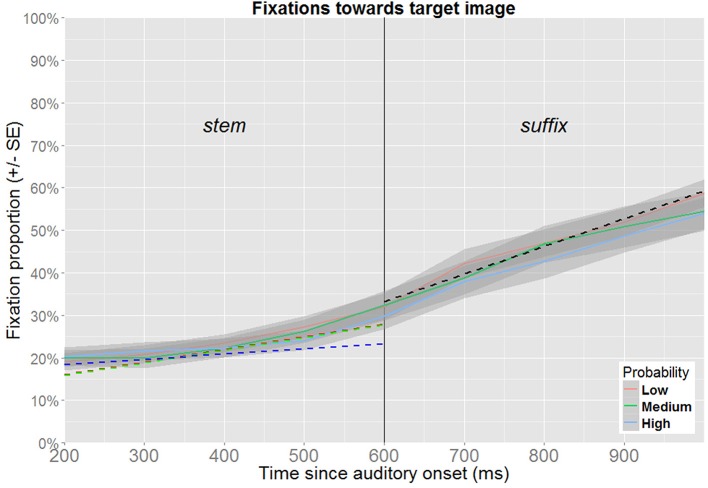
Fixation proportions toward the target according to its probability (no competitor trials). Fixation proportions were aggregated in bins of 100 ms for each participant, and will not correspond directly to the model estimates (dotted lines), where random effects are taken into consideration. In the time window corresponding to the processing of the suffix, model estimates only contain an effect of time, and are therefore not color coded.